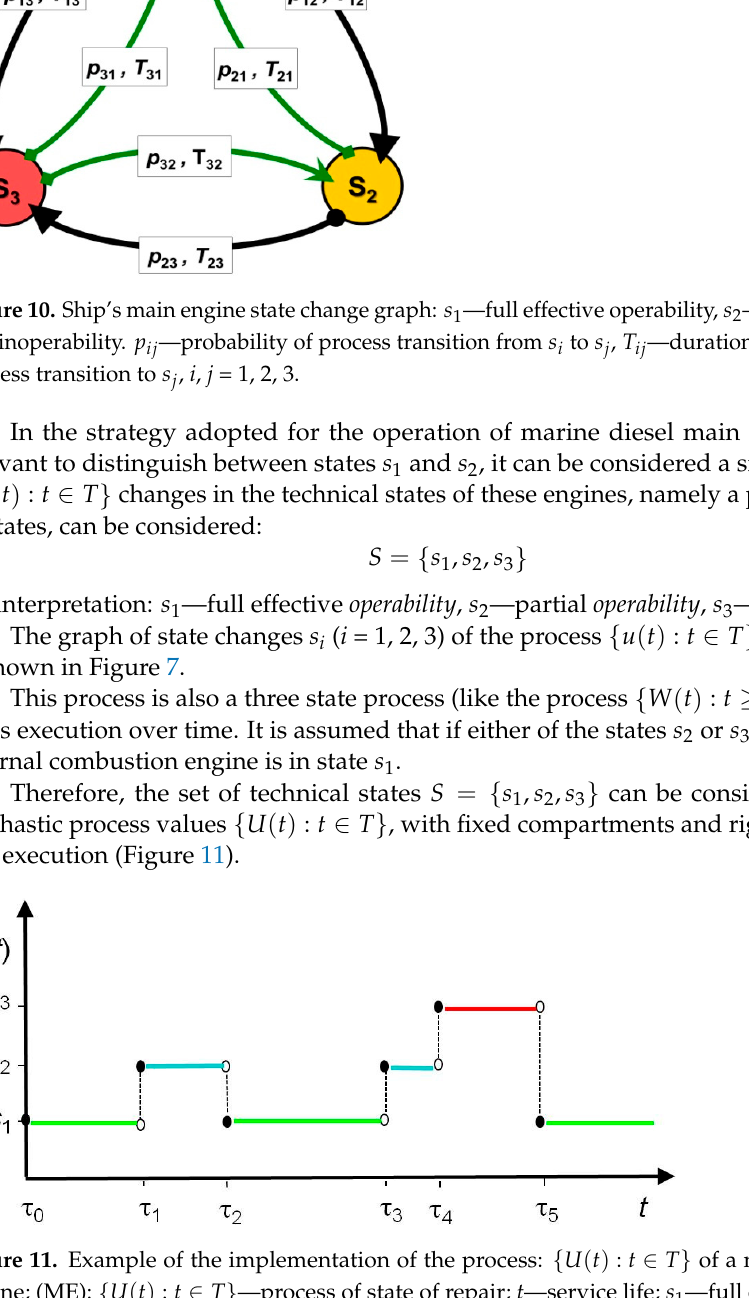
15 of 20 Figure 9. Example of the implementation of the { W(t): t ∈ T } process of a compression ignition engine: { W(t) : t ∈ T }—process of state changes; t —operating time; s 1 —full serviceability; s 2 — incomplete serviceability; s 3 —partial serviceability; s 4 —unsuitable state; periods of time during which the use of a PTO/PTI system is justified. An important feature of the graph shown in Figure 9 is that the relationship between states reflecting the execution of full recovery to state 𝑠 (cid:2869) is taken into account if the engine is in state 𝑠 (cid:2870) or 𝑠 (cid:2871) . Therefore, this variant of 𝑠 (cid:3036) ∈ S condition means changes should be